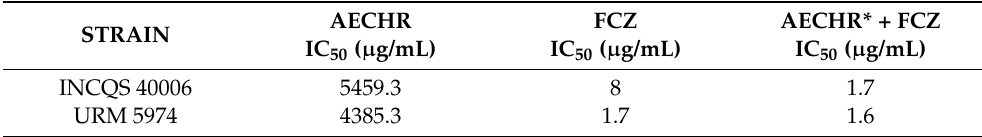
Table 3. Half-maximal inhibitory concentration (IC 50 ) of C. heliotropiifolius extract and fluconazole against C. albicans strains.AECHR—aqueous extract of C. heliotropiifolius roots; AECHR*—subinhibitory concentration of the extract (1024 µ g/mL); FCZ—fluconazole; INCQS—National Institute of Quality Control in Health; URM—University Recife Mycology. ( p <